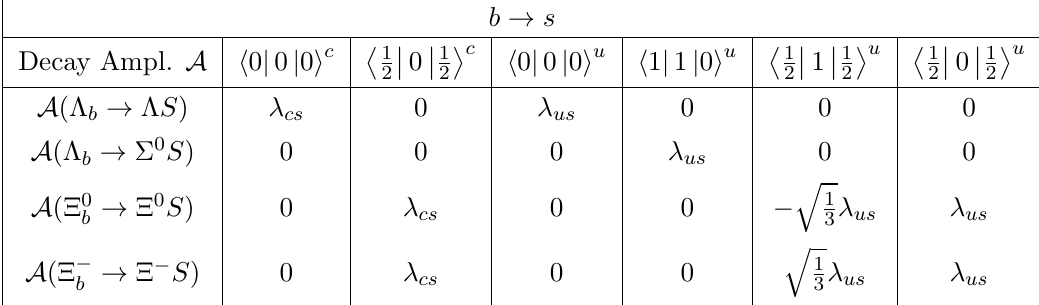
Table 3. Isospin decomposition for b ! s transitions.